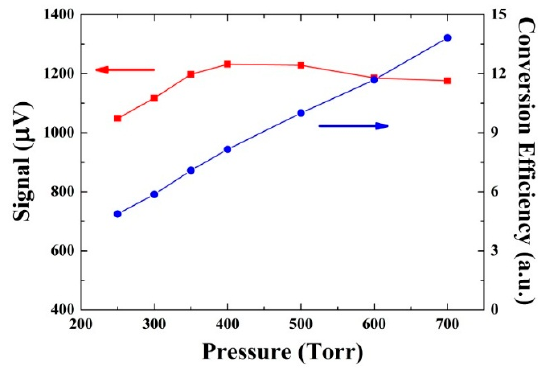
Figure 6. Measured CO QEPAS signals (squares) and corresponding conversion efficiency ε ( P ) (circles) as a function of the gas pressure.